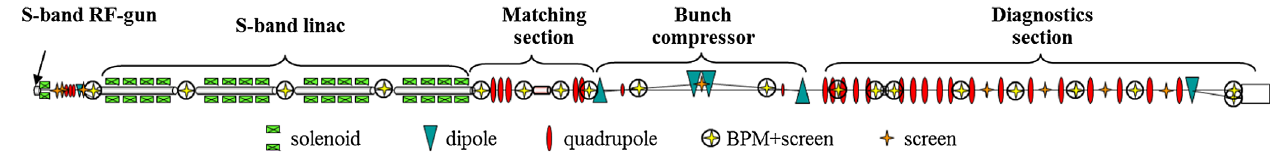
FIG. 1. Schematic layout of the SwissFEL Injector Test